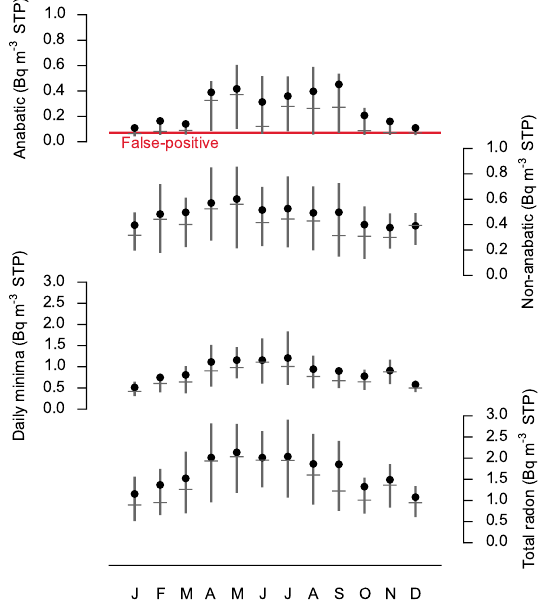
Figure 6. Seasonal cycle of decomposed daily radon concentra- tion using the definitions shown in Fig. 2. The annual mean false- positive contribution is included on the anabatic plot, showing that anabatic flows are detected with confidence during the months of April–September. The symbols have the same meaning as in Fig.